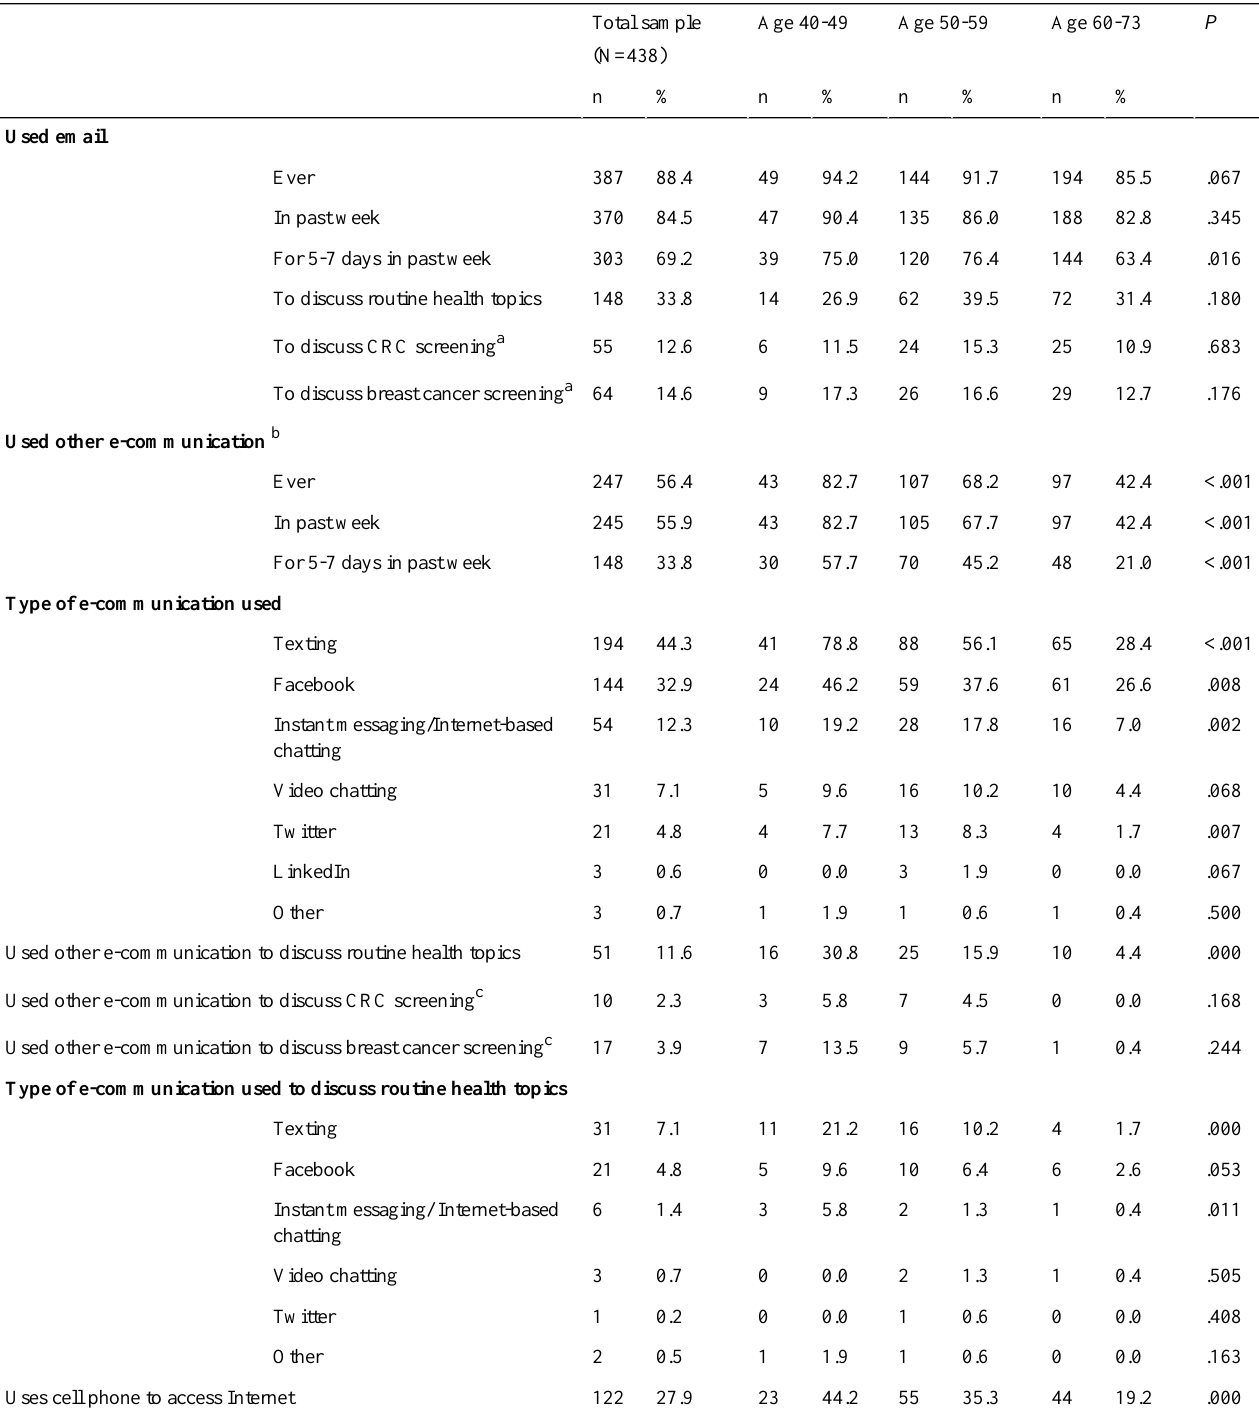
Table 2. Use of email and social media to discuss health-related topics and to discuss cancer